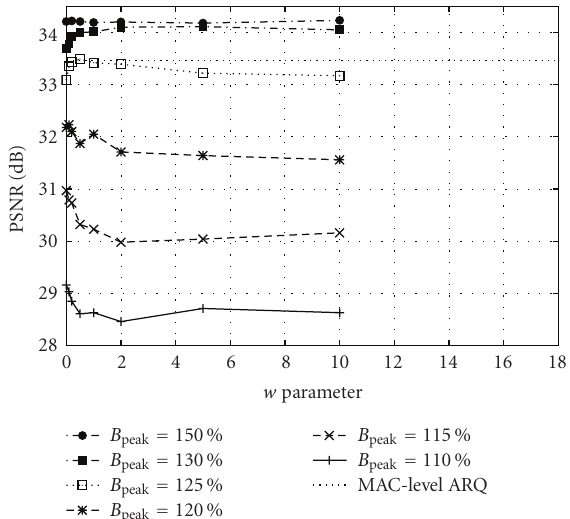
Figure 5: PSNR as a function of w parameter for the proposed per- ceptual ARQ technique ( tempete